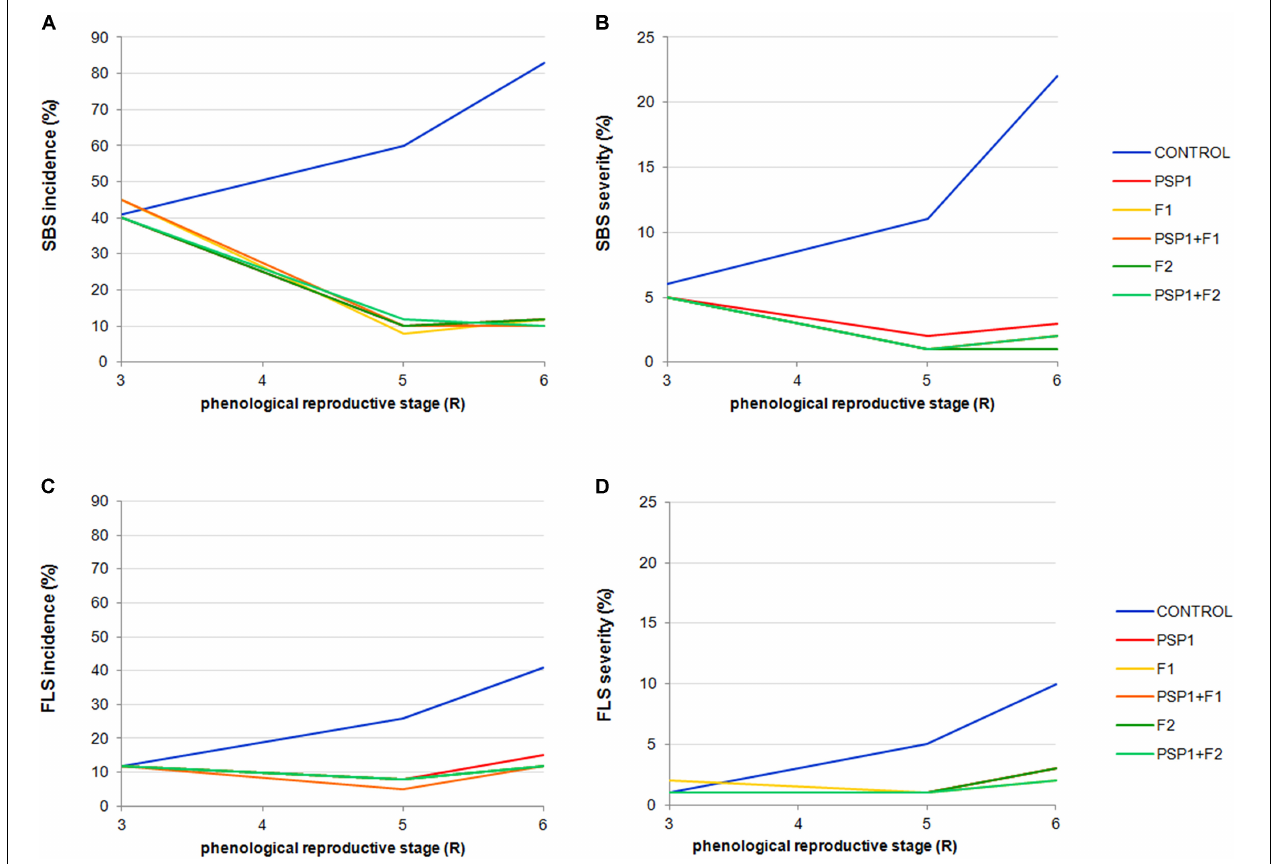
FIGURE 4 | Soybean field trial conducted in Tandil during growing season 2013/14. Incidence and severity of SBS evaluated at phenological stages R3, R5, and R6 are shown in (A,B) , respectively. Incidence and severity of FPS evaluated at phenological stages R3, R5, and R6 are shown in (C,D) , respectively. Treatments were control (received standard soybean crop management without foliar fungicide or biocontrol treatment), PSP1, fungicide F1, fungicide F2, PSP1 plus fungicide F1 and PSP1 plus fungicide F2. The collected data, although highly informative, was not sufficient to perform a thorough statistical